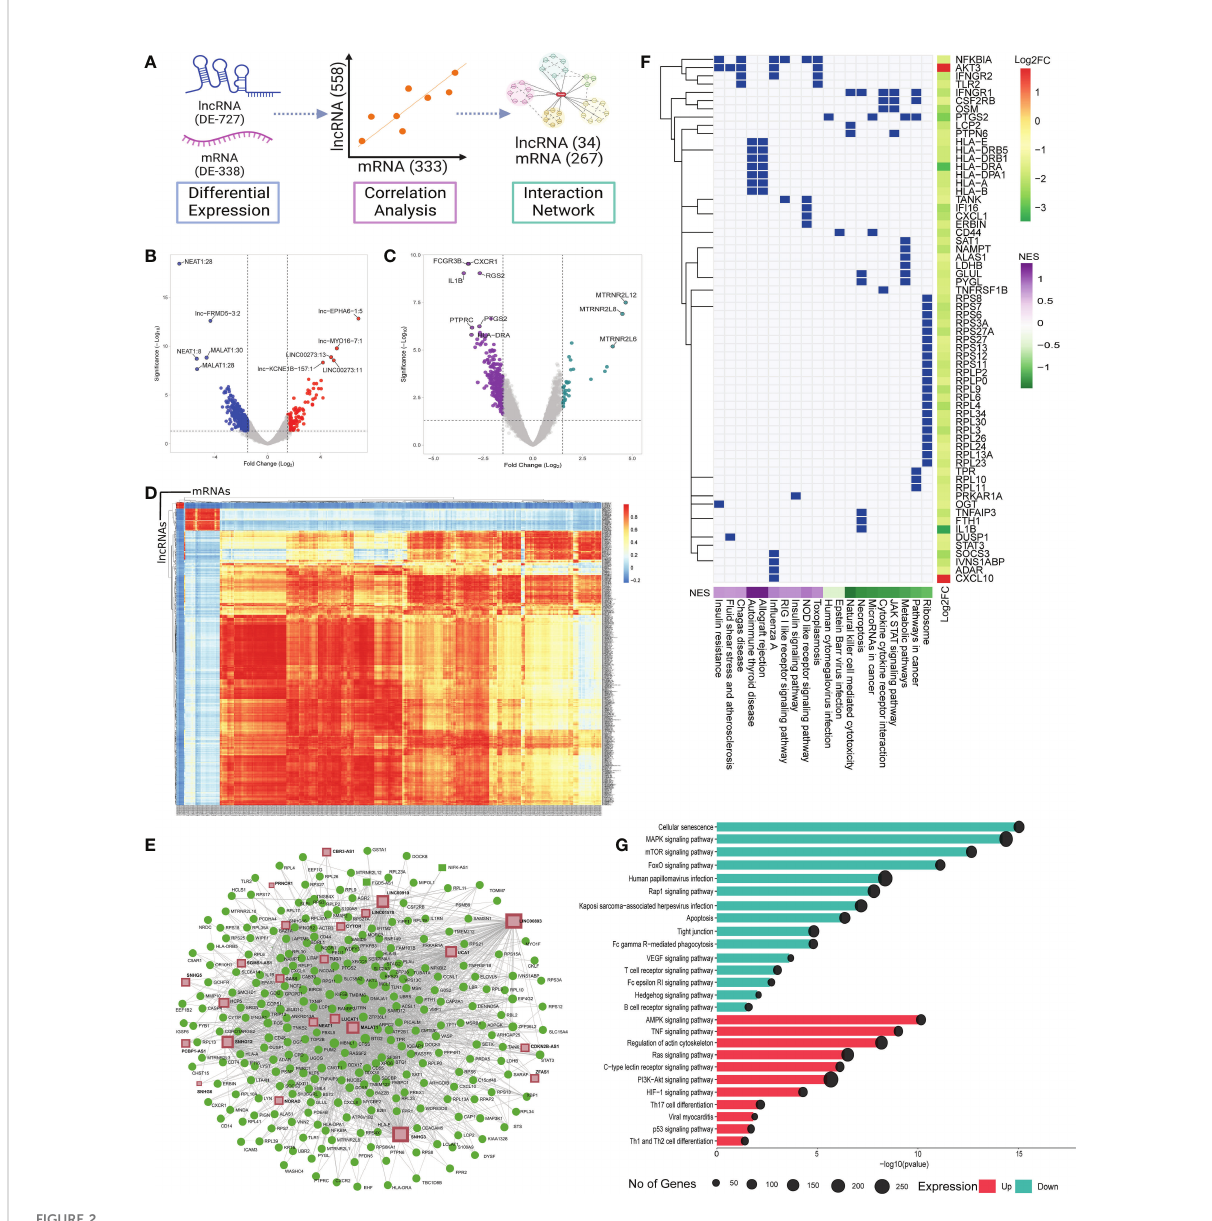
FIGURE 2 Differential expression, Co-expression and functional Role of the lncRNAs and the mRNAs between the vaccination breakthroughs and the unvaccinated. (A) Illustration of the DE analysis of the lncRNAs and the mRNAs, lncRNA-mRNA co-expression and interactions. (B) and (C) Volcano plot of the differential expression of the lncRNAs and the mRNAs between the vaccination breakthroughs and the unvaccinated, respectively. (D) Heatmap representing Pearson correlation coef fi cient between the DE lncRNAs and the mRNAs. (E) LncRNA-mRNA interaction network with Green dots representing the mRNAs and brown squares for the lncRNAs. (F) GSEA of the network interacting genes. Green box indicates involvement of a gene in a speci fi c pathway. Side color bar indicates Log2 fold change of the genes, while the bottom color bar indicates the Normalized Enrichment Score (NES) of the pathways. (G) Pathway enrichment of the network interacting lncRNAs. Color represents the expression of the pathways, and the circle size highlights the number of genes involved in the